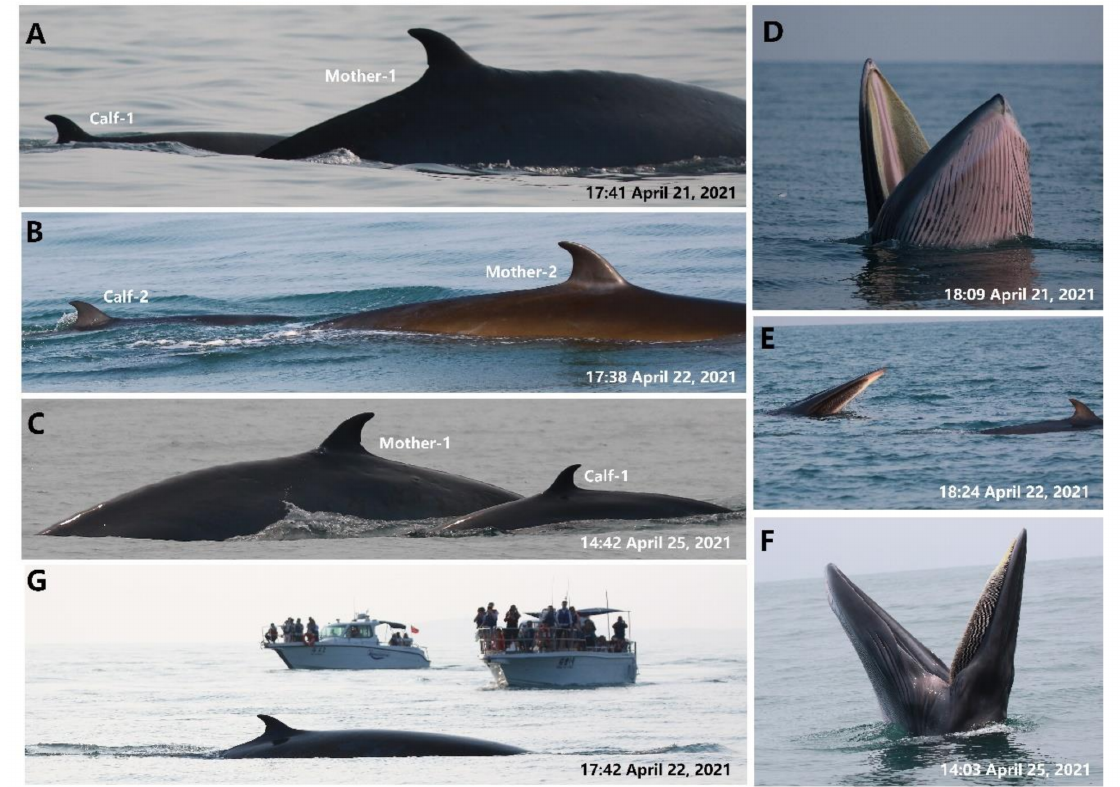
Figure 2. Photographic examples of ( A – C ) mother–calf pair of Bryde’s whales in the Beibu Gulf on 21, 22, and 25 April 2021. Two mothers (Mother-1, -2) and two calves (Calf-1, -2) were identified; ( D – F ) tread-water feeding behaviors of Bryde’s whales on 21, 22, and 25 April 2021; ( G ) whale-watching activities in the waters around Weizhou